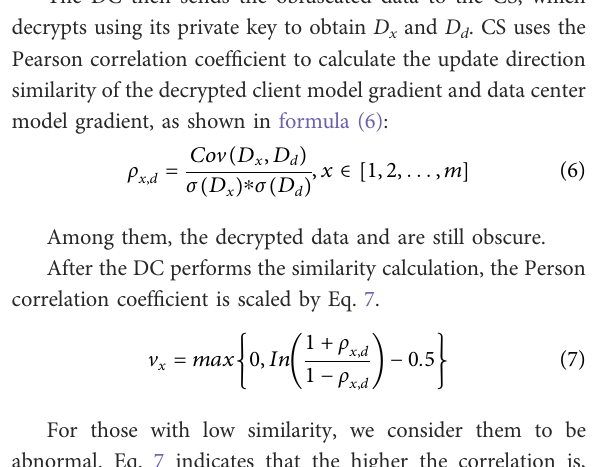
Algorithm 1. Similarity Calculation